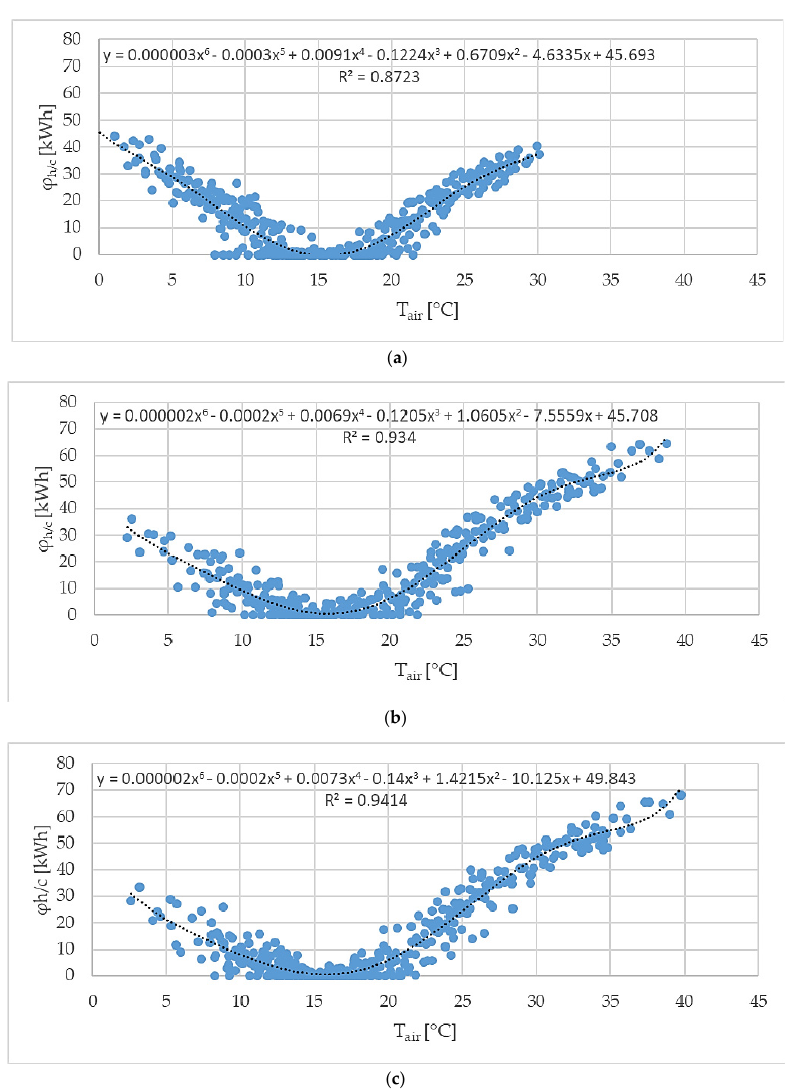
Figure 5. Non-linear regression between daily energy demand of the building and outdoor air temperature: ( a ) 2020 current scenario, ( b ) future scenario 2050 RCP4.5 and ( c ) future scenario 2050 RCP8.5. Trendlines, respective polynomial equations and R-squares are reported on each graph.